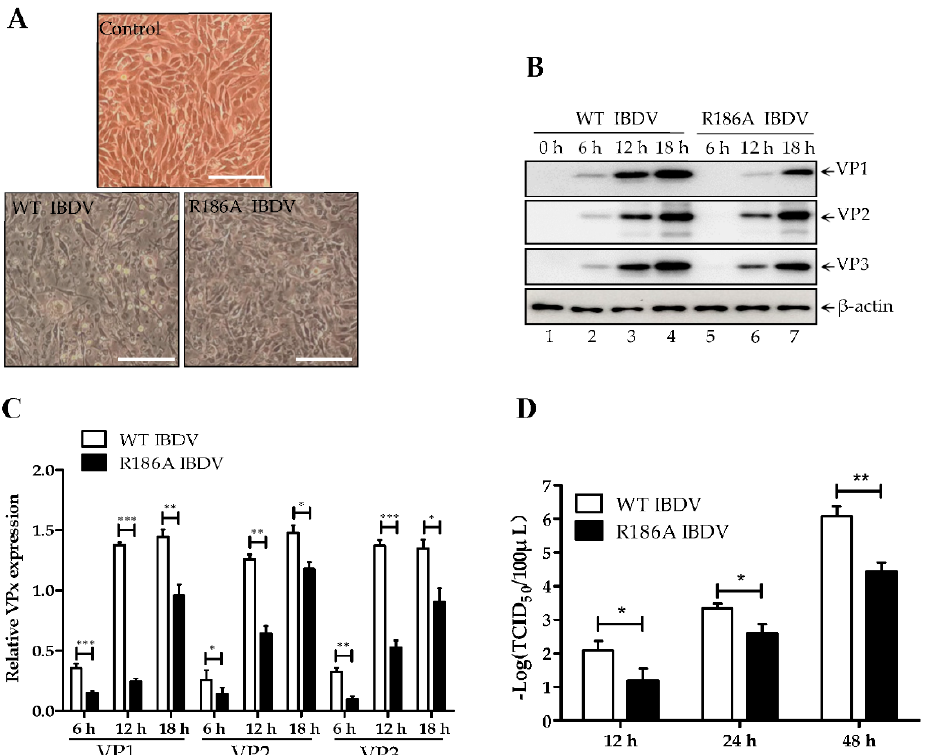
Figure 5. Mutation of Arg 186 damages IBDV proliferation ability. ( A ) The supernatant of 293T cells co-transfected with indicated plasmids was passaged in DF-1 cells at 48 h post-transfection, and the images of CPE were taken under a phase-contrast microcopy at 48 h post-infection. Scale bar, 100 μm. ( B ) DF-1 cells infected with 0.1 MOI indicated IBDV at 6 h, 12 h, and 18 h were analyzed by western blot using VP1/VP2/VP3 antibodies. ( C ) Comparison of the expression of VP1/VP2/VP3 in different lanes in ( B ). The density of VP1/VP2/VP3 and β -actin were quantified by Image J. Data were presented as means ± SD. * p < 0.5; ** p < 0.01; *** p < 0.01. ( D ) Monolayer DF-1 cells (triplicates in 12-well plate) were infected with WT IBDV or R186A IBDV at 0.1 MOI at 12 h, 24 h, and 48 h; the virus titers in the supernatant were determined by TCID 50 assay. Data were presented as means± SD. ns, not significant; * p < 0.5; ** p < 0.01.